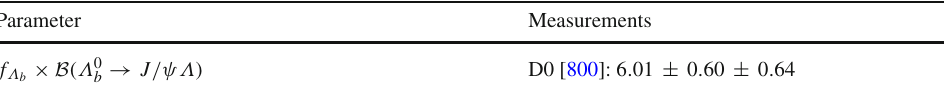
decay to charmonium [ 10 − 5 ] b